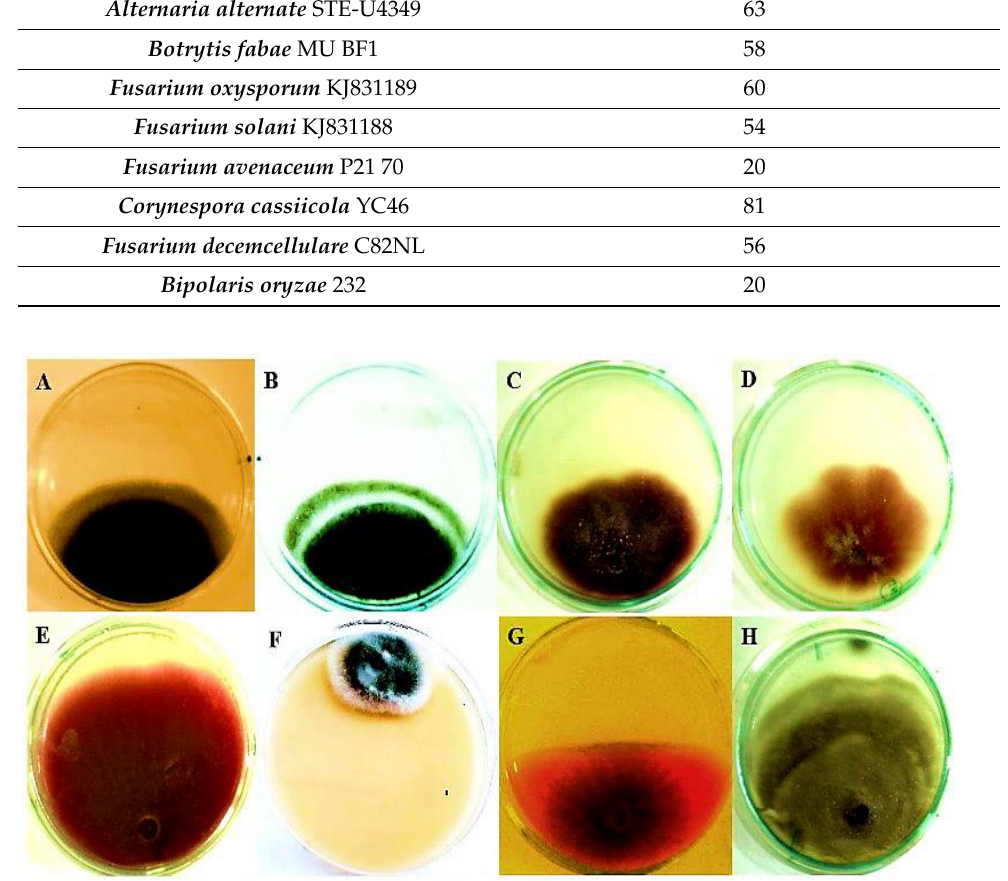
Figure 14. Antifungal activity of crude xylanase against some plant pathogenic fungi ( A ) Alternaria alternate STE-U4349, ( B ) Botrytis fabae MU BF1,( C ) Fusarium oxysporum KJ831189, ( D ) Fusarium solani KJ831188, ( E ) Fusarium avenaceum P21 70, ( F ) Corynesporacassiicola YC46, ( G ) Fusarium decemcellulare C82NL, and ( H ) Bipolaris oryzae 232.